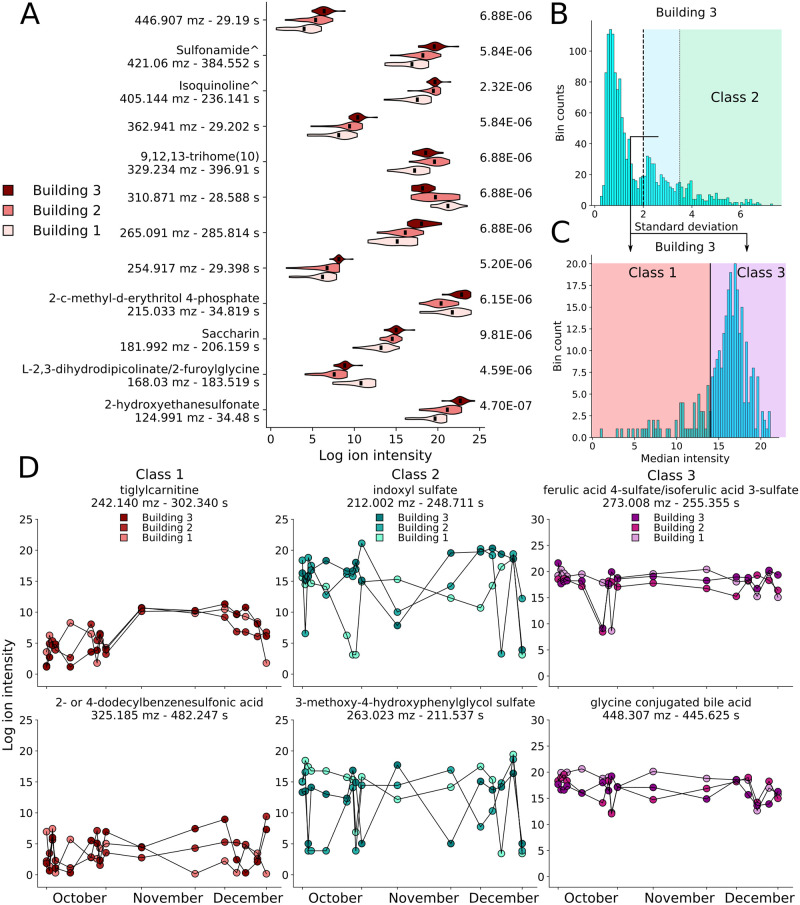
12 stable features are statistically different between buildings, and unstable features display three temporal classes.(A) Violin plot of all 12 significant features depicting building-to-building differences, distributions and FDR corrected P-values (right column). Names are levels 2 or 3 putative identifications (^ depicts level 3; Sulfonamide: N’-(3-chloro-2,4,6-trifluorophenyl)sulfonyl-1-adamantanecarbohydrazide, Isoquinoline: 2-[[2-[2-(2,3-dihydroindol-1-yl)-2-oxoethyl]-1-oxo-5-isoquinolinyl]oxy]acetic acid ethyl ester, S2 Table). (B) Unstable feature separation for Building 3, depicting features with through-time standard deviation in excess of 3.5 (Class 2) and those below. (C) Unstable feature separation for Building 3, showing features with median log intensity separated by a median intensity of 14 (Class 1). (D) Unstable feature time courses for select metabolites of the three classes: Class 1 features (left column); Class 2 features (middle column); and Class 3 features (right column, S3 Table).